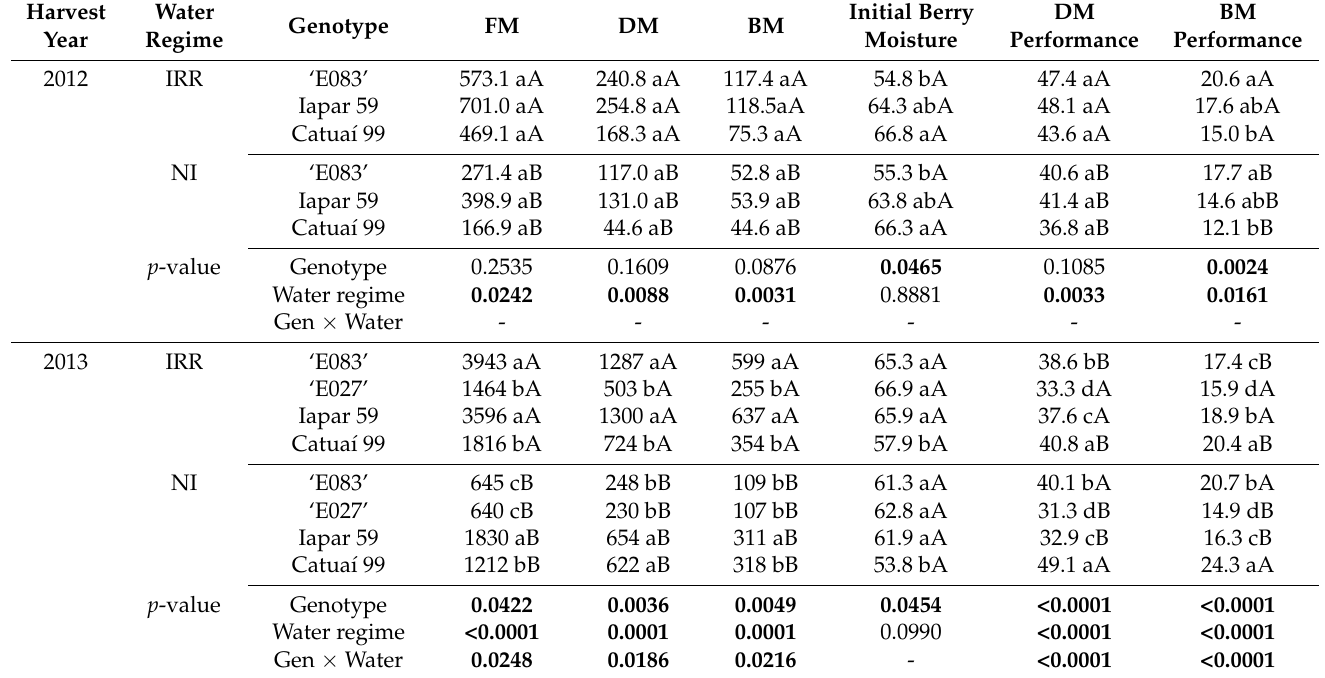
Table 1. Components of the berry and bean yields: fresh berry mass (FM), dry berry mass (DM),